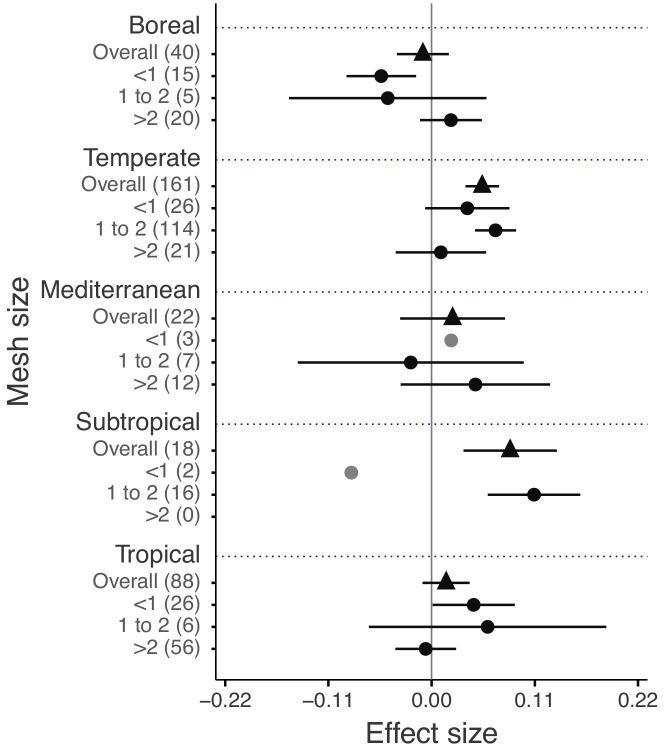
Litter mixture effects on mass loss from litterbags for each biome separately and distinguishing among overall (triangles) and mesh size-specific (circles) effects. Effect sizes were calculated as the log response ratio between observed and expected values for each response variable and 95% bootstrap confidence intervals (CI) are shown. Data from the final harvest of the decomposition experiment were used to calculate the effect sizes. The solid vertical black line indicates no effects (mean effect size = 0, observed values = expected values). Mean effect size >0 indicates synergistic effects (observed values > expected values), while mean effect size <0 indicates antagonistic effects (observed values < expected values). The non-additive effects (synergistic or antagonistic) are significant at α = 0.05 if the CI of the effect size does not overlap 0, while the effects are additive when there is overlap. The values in parentheses denote the number of observations. The grey circles indicate 95% bootstrap CI that was too large to show.